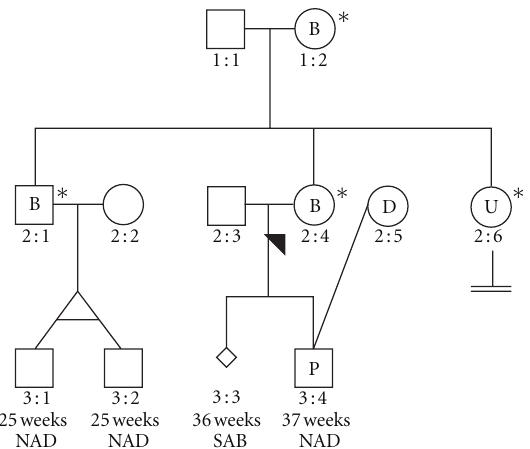
Figure 1: Pedigree. ∗ A ff ected individual detected. B: balanced translocation detected; 46, X, t(X;18)(q22.3;q23). U: Unbalanced translocation detected; 46, X, der(X), t(X;18)(q22.3;q23). D: donor—individual 2:4 carried pregnancy 3:4 using donor egg (from individual 2 :5) and partner’s sperm (from individual 2: 3). P: Pregnancy resulted from donor egg (from individual 2:5). SAB: spontaneous abortion (individual 3 :3). NAD: no abnormalities